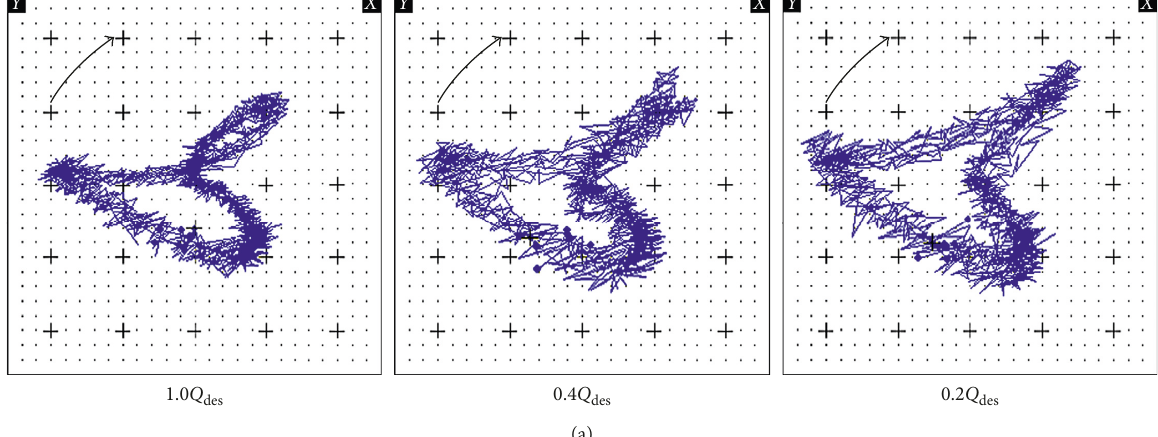
Figure 8: Vorticity distribution of shooting section under different flow rate conditions. (a) 1.0 Q